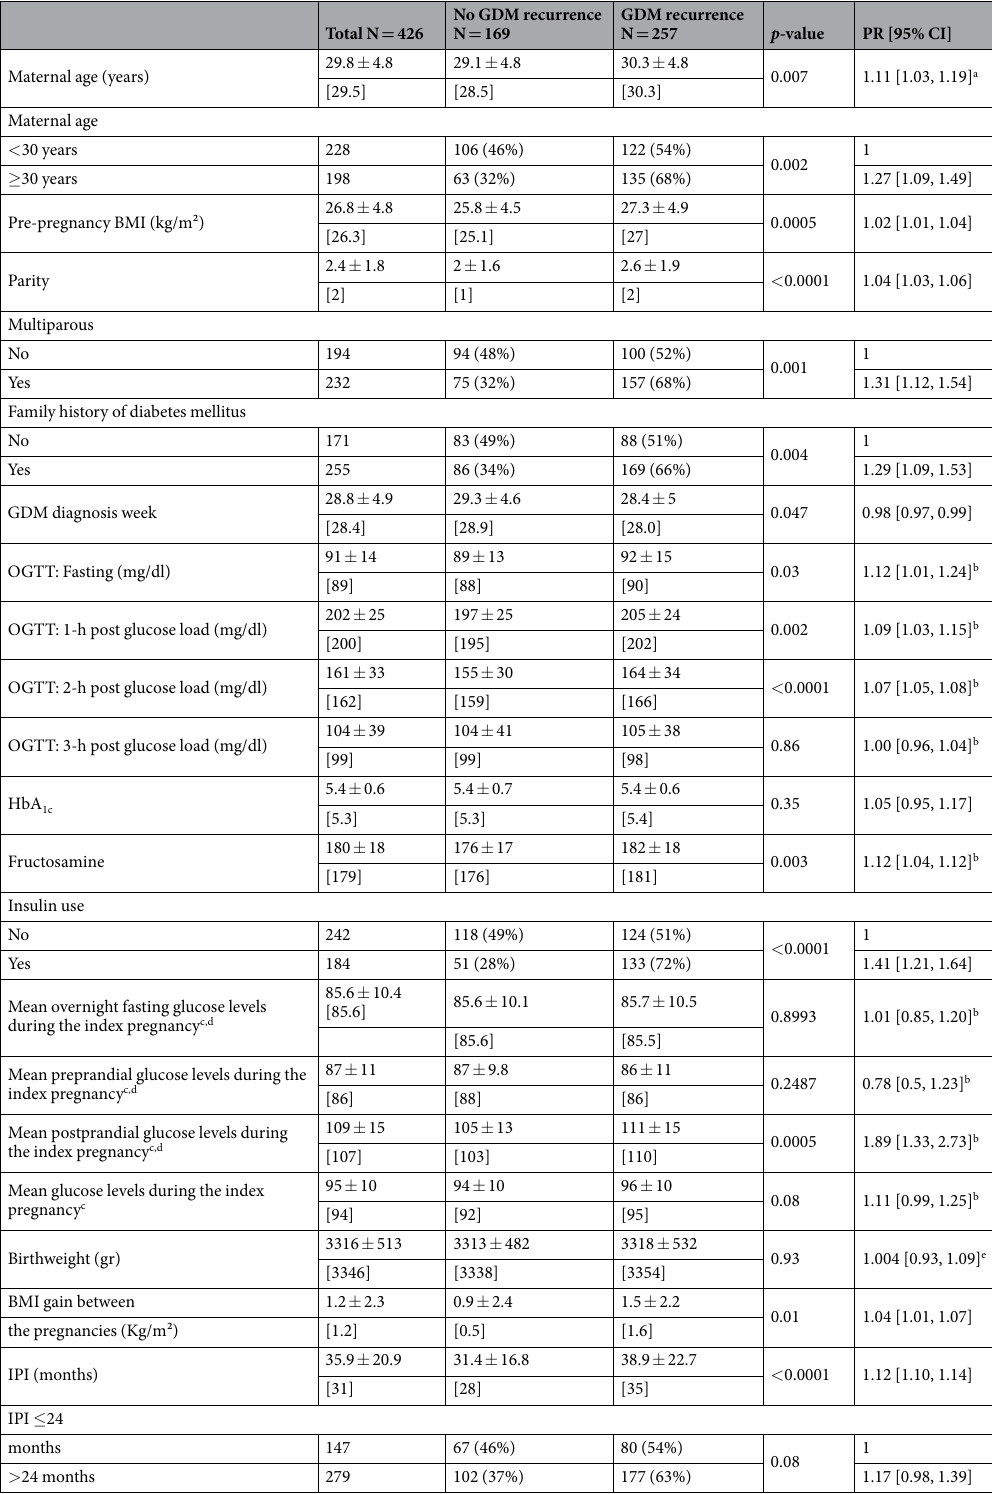
Table 1. Baseline characteristics of the 426 women according to GDM recurrence. Continuous variables are presented with mean ± standard deviation [median]. PR = prevalence ratio; CI = confidence interval; IPI = inter-pregnancy interval; GDM = gestational diabetes mellitus; OGTT = oral glucose tolerance test; BMI = body mass index; HbA 1c = Hemoglobin A1c. a For every 5 year increase. b For every 20 units increase. c Adjusted for the number of glucose days reported. d Included only 303 women with specified glucose levels. e For 500 gr